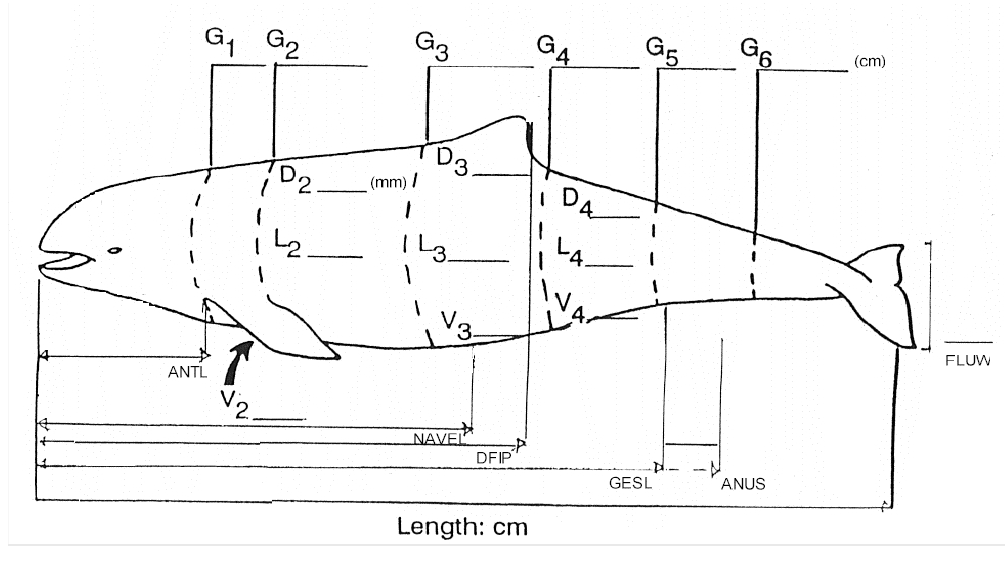
Fig. 3 . Diagram of the standard measurements and sampling sites on harbour porpoise. G 1 -G 6 are girths, D 2 -D 4 are dorsal, L 2 -L 4 are lateral and V 2 -V 4 are ventral blubber thicknesses. Other length measurements indicated are taken in a direct straight line and not along the body